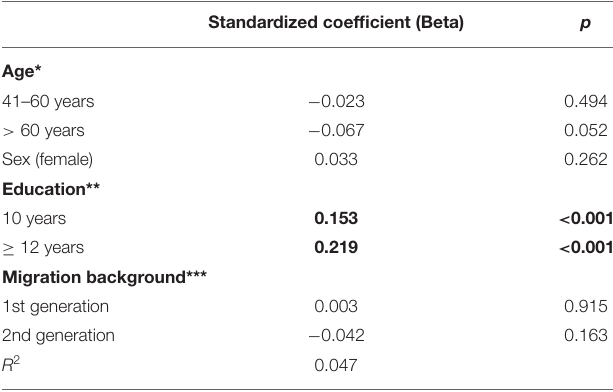
TABLE 3 | Social factors and capability of dealing with emergency cases (sum scale): linear regression model ( N =